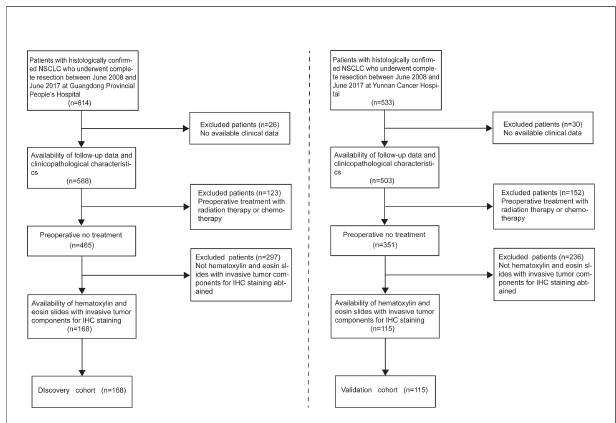
FIGURE 1 | The fl ow diagram for patient